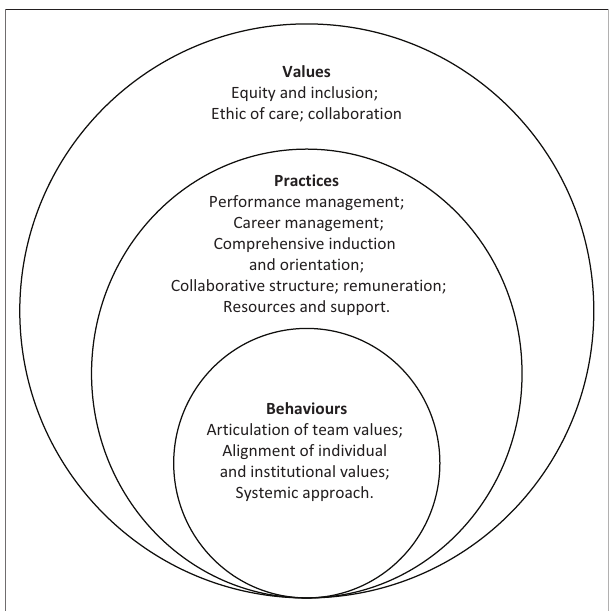
FIGURE 1: Institutional culture that supports academic career